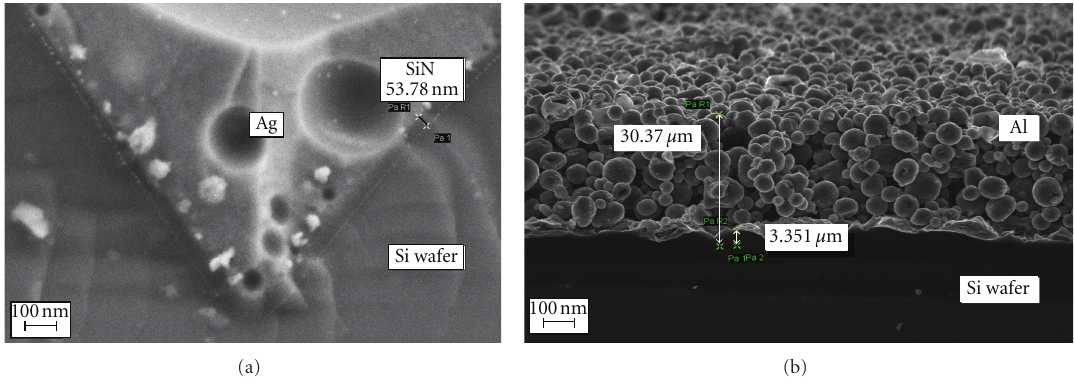
Figure 4: (a) SiN film on pyramidal textured Si wafer, (b) cross-sectional image of Al fired on the Si wafer.